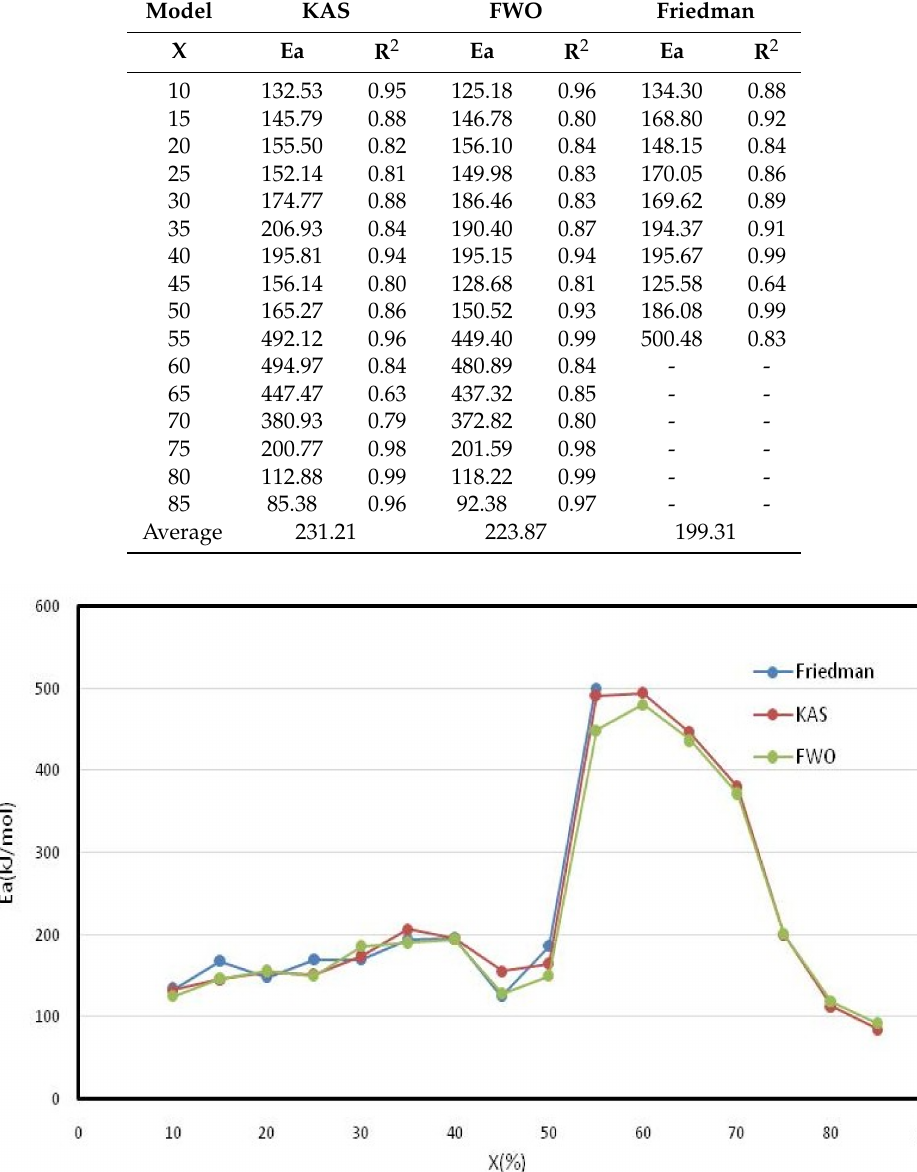
Figure 3. Activation energy variation according to KAS, FWO and Friedman